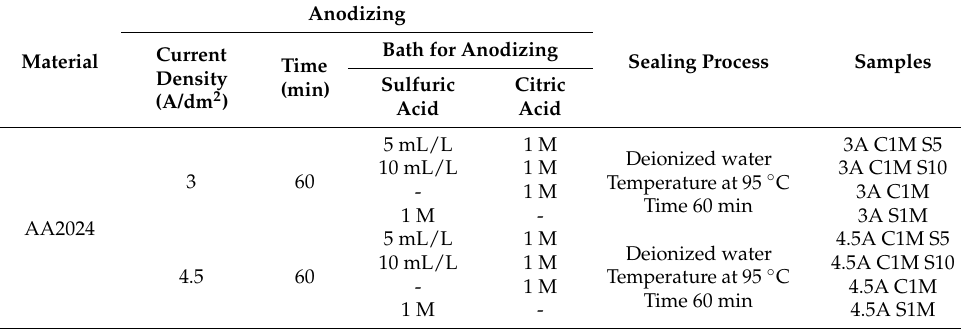
Table 1. Anodizing process parameters and sample